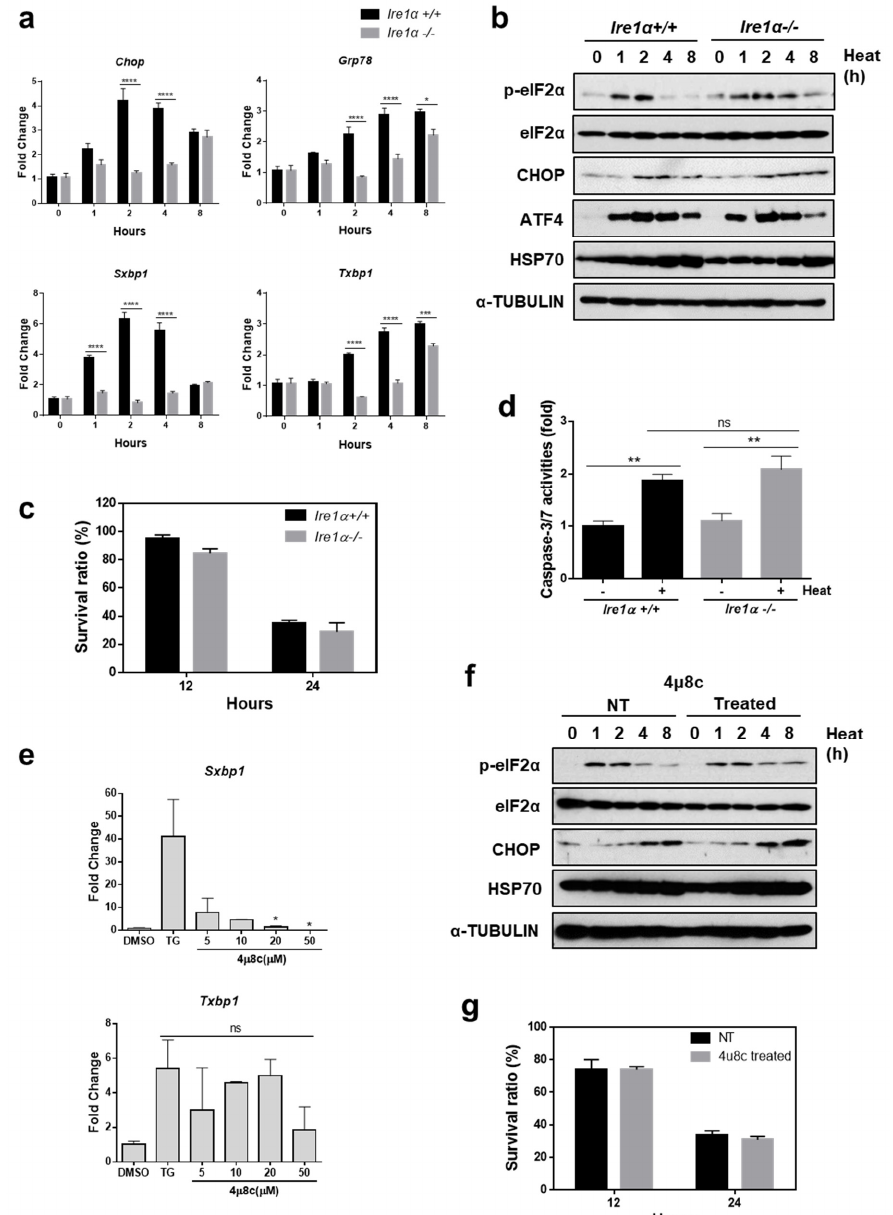
Figure 2. The IRE1 α pathway does not protect cells from heat stress-mediated death. ( a ) Quantitative RT-PCR was performed using total RNA, extracted from Ire1 α − / − and Ire1 α +/+ MEFs which were incubated at 42 ◦ C for indicated time periods. Data are presented as means ± SEM. (n = 3 independent experiments). ( b ) Protein expression under conditions of hyperthermia was measured. Following incubation at 42 ◦ C, cell lysates were collected at the indicated times for western blot analysis. ( c ) Cell viability was measured in Ire1 α − / − and Ire1 α +/+ MEFs which were incubated at 42 ◦ C for indicated time periods. ( d ) Caspase 3/7 activity was detected in Ire1 α − / − and Ire1 α +/+ MEFs which were incubated at 42 ◦ C for 12 h. ( e ) Expression of sXBP1 (spliced form) and tXBP (total form) were measured using MEFs treated with 4 µ 8c at indicated doses in the presence or absence of Tg (300 nM) for 12 h. ( f ) Protein expression under conditions of hyperthermia was measured in the presence or absence of 4 µ 8c (20 µ M). ( g ) Cell viability was measured in Ire1 α − / − and Ire1 α +/+ MEFs which were incubated at 42 ◦ C for indicated time periods in the presence or absence of 4 µ 8c (20 µ M). * p < 0.05; ** p < 0.01; *** p < 0.001; **** p <